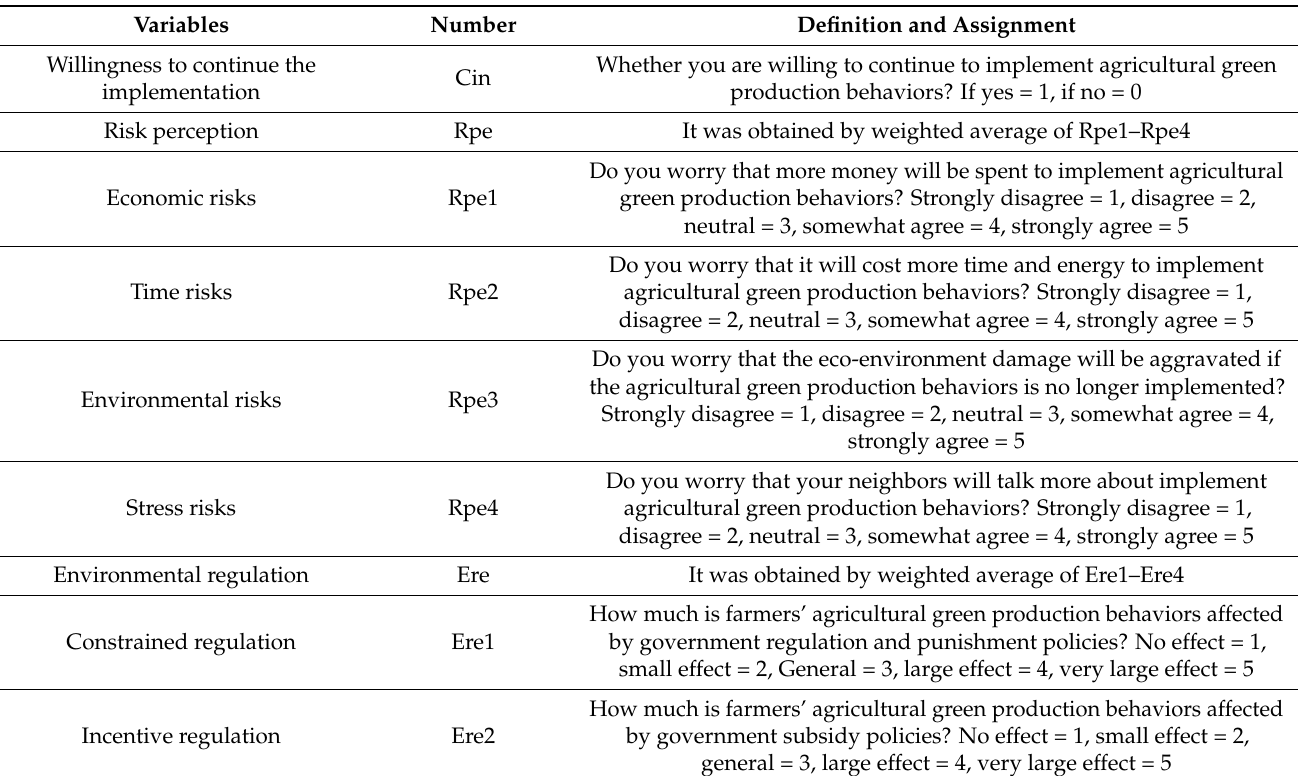
Table 1. Measurement items of